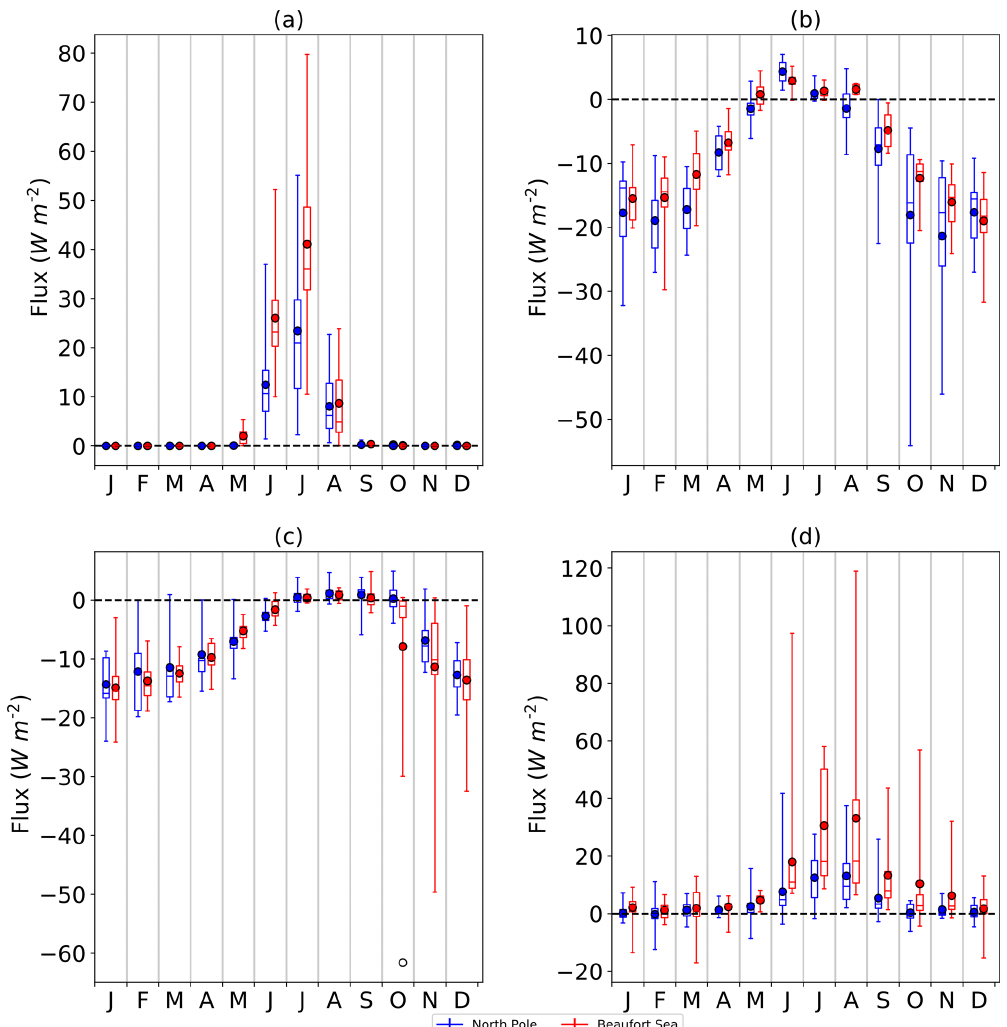
Figure 7. Fluxes of (a) top melting, (b) top conductive flux, (c) basal conductive flux and (d) ocean heat flux, estimated from the IMB data, shown for North Pole (blue) and Beaufort Sea (red) regions. For each month, flux and region, the distribution is indicated by a boxplot showing range, interquartile range, median (horizontal lines) and mean (filled circles). For all fluxes, the convention is that downwards is